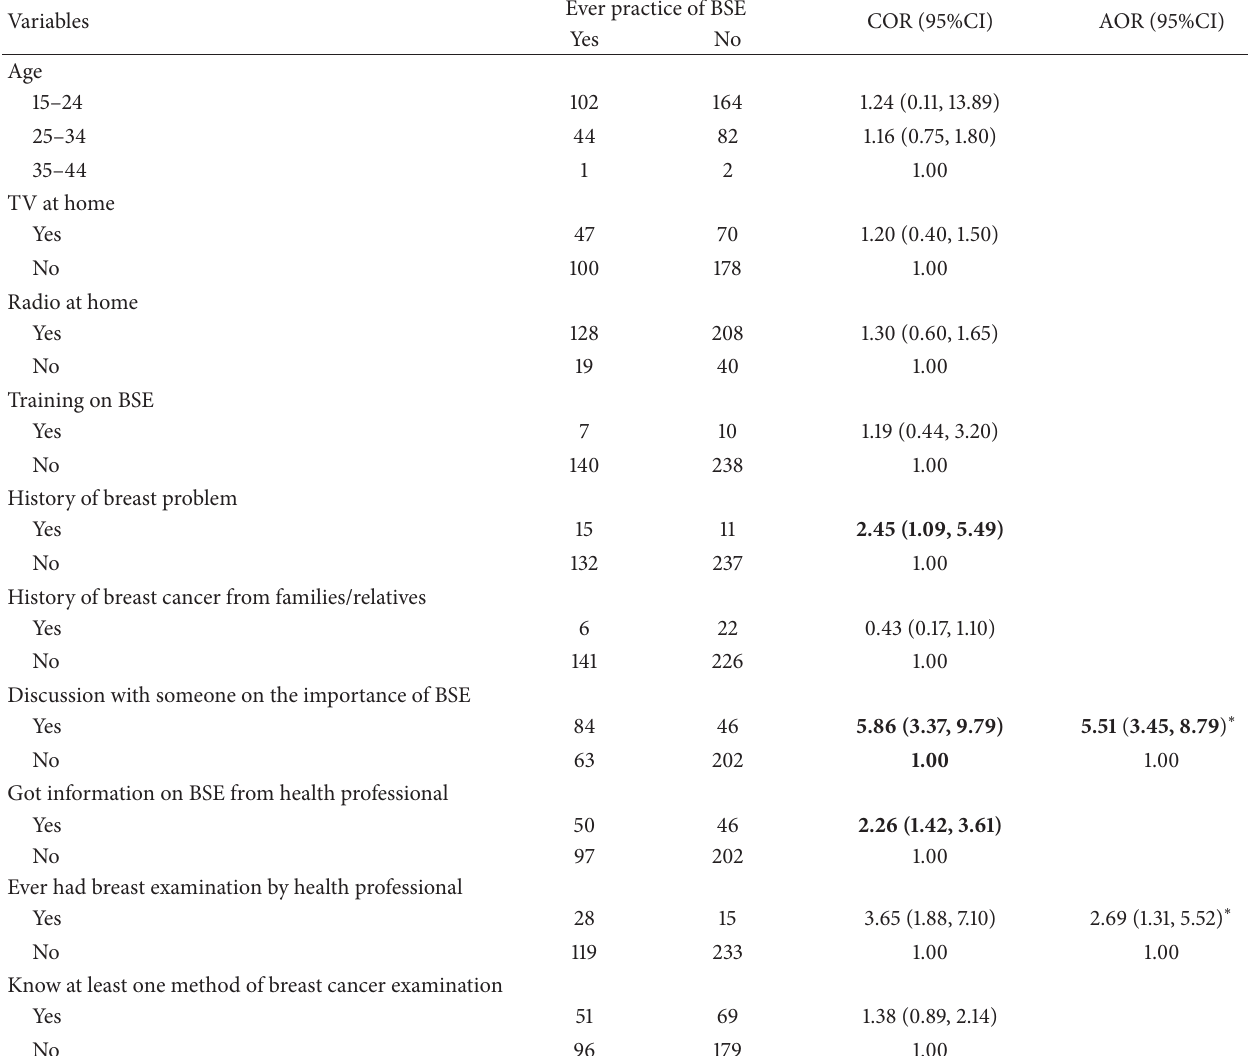
Table 4: Factors associated with breast self-examination among HEWs in West Gojjam Zone, Northwest Ethiopia, October 2012.